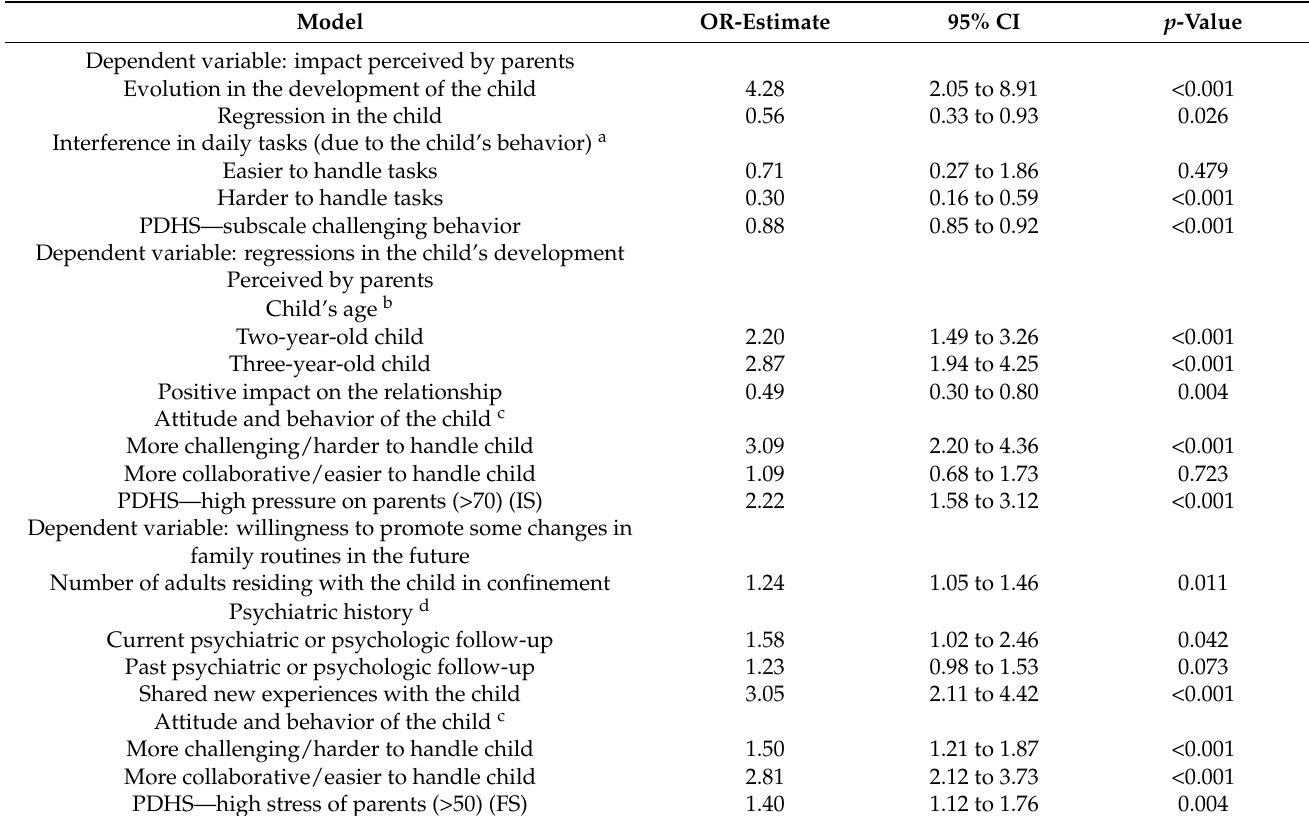
Table 2. Results of multivariate regression